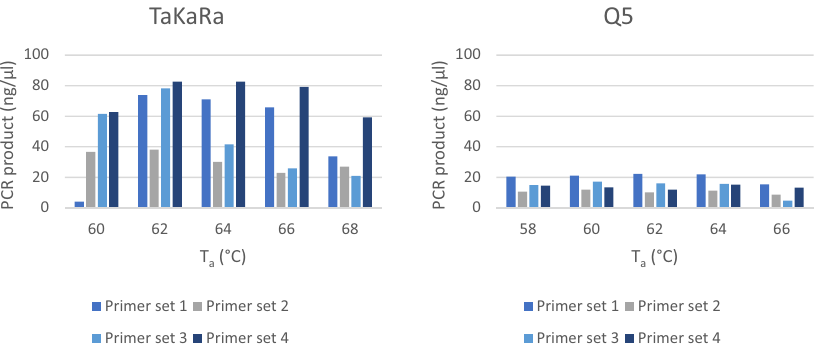
Figure 2. Varying T a and the respective amount of PCR product, using commercial human DNA (100 ng) with four different primer sets, split for the TaKaRa and Q5 polymerase. T a = primer annealing temperature; PCR = polymerase chain reaction.